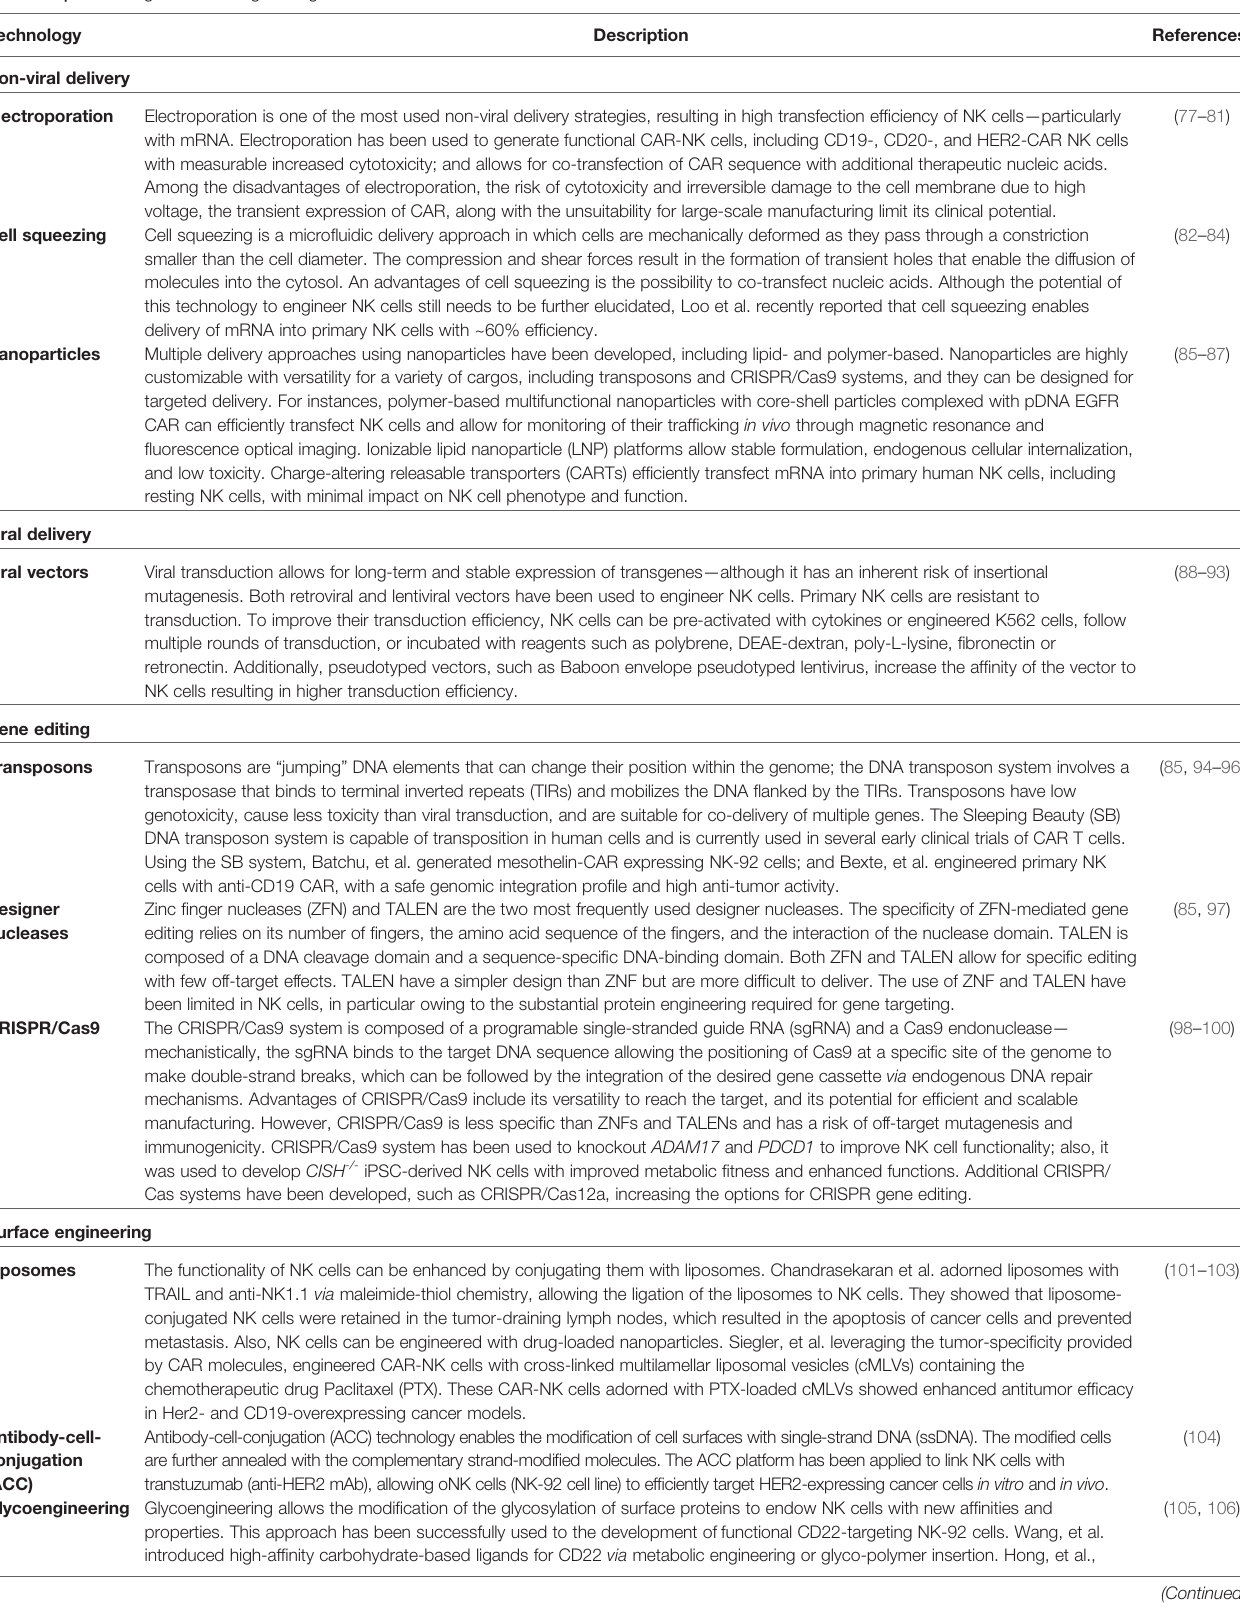
TABLE 1 | Technologies for the engineering of NK